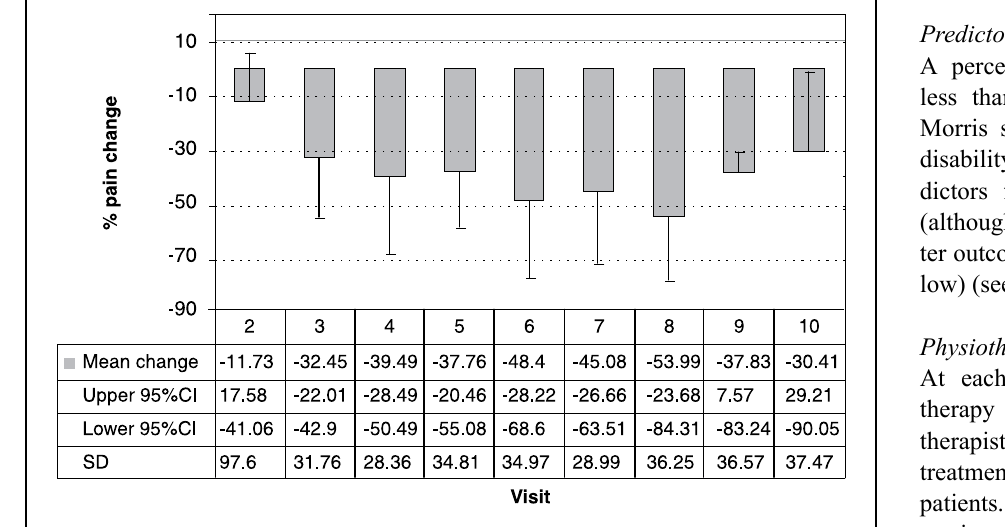
Figure 3: Mean pain change (% change) for pain previous